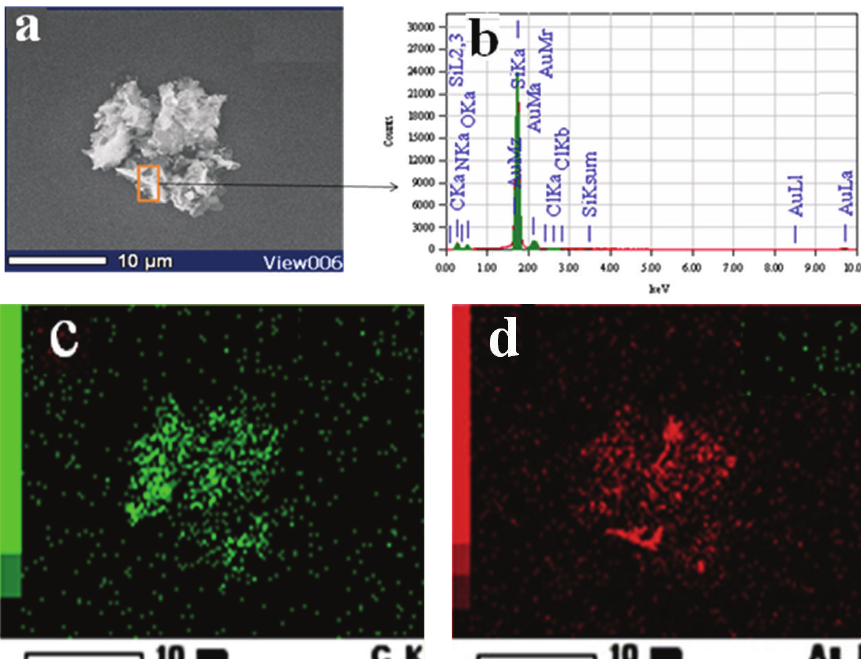
Figure 5: (a) SEM image and (b) results of the EDX element analysis of RGO-Au. (c) EDXA-C and (d) EDXA-Au mapping image of sample RGO-Au. The bright spots show the distribution of C and Au elements on the RGO-Au